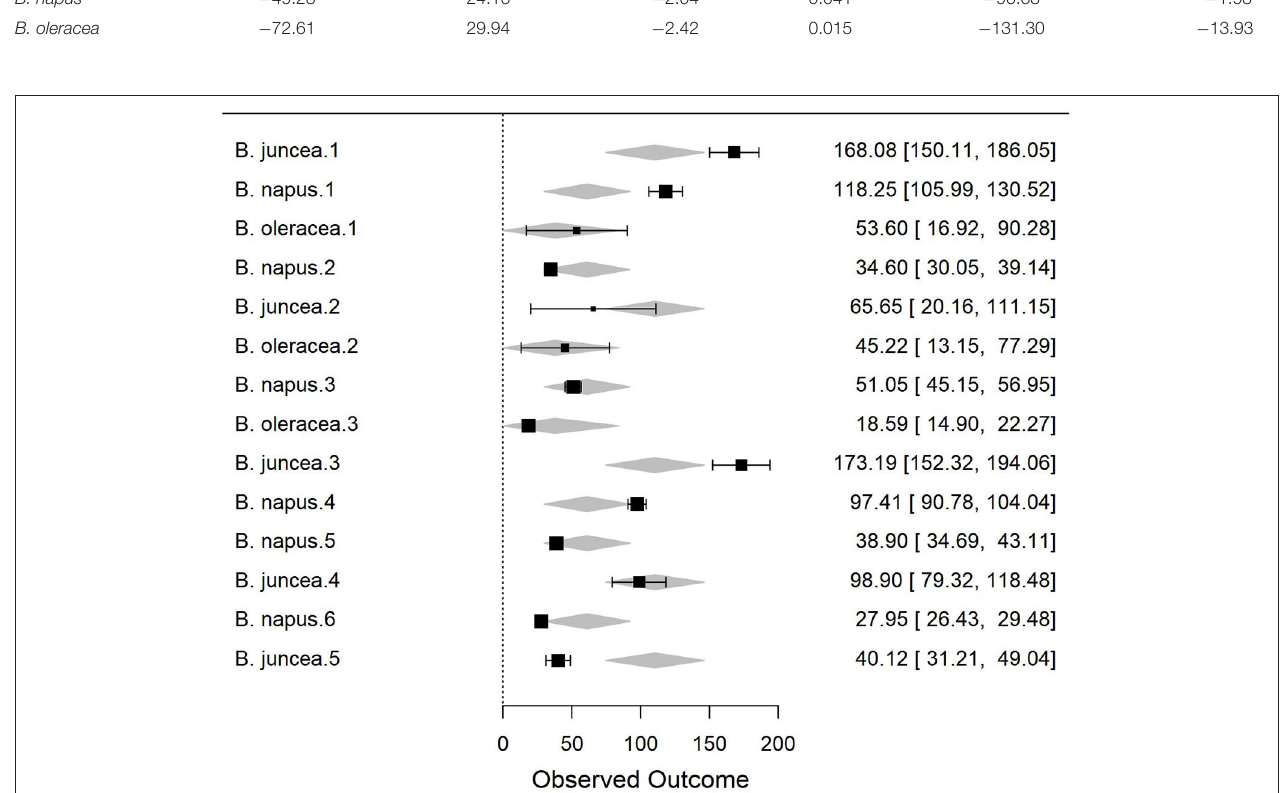
FIGURE 7 | Forest plot of the meta-analysis using the random-effects model and standard REML procedure. The effect sizes of three species compared: Brassica juncea , B. napus, and B. oleracea . For individual study, outcome value or effect estimates (box) along with the confidence intervals (CI) and overall effect (diamond) are